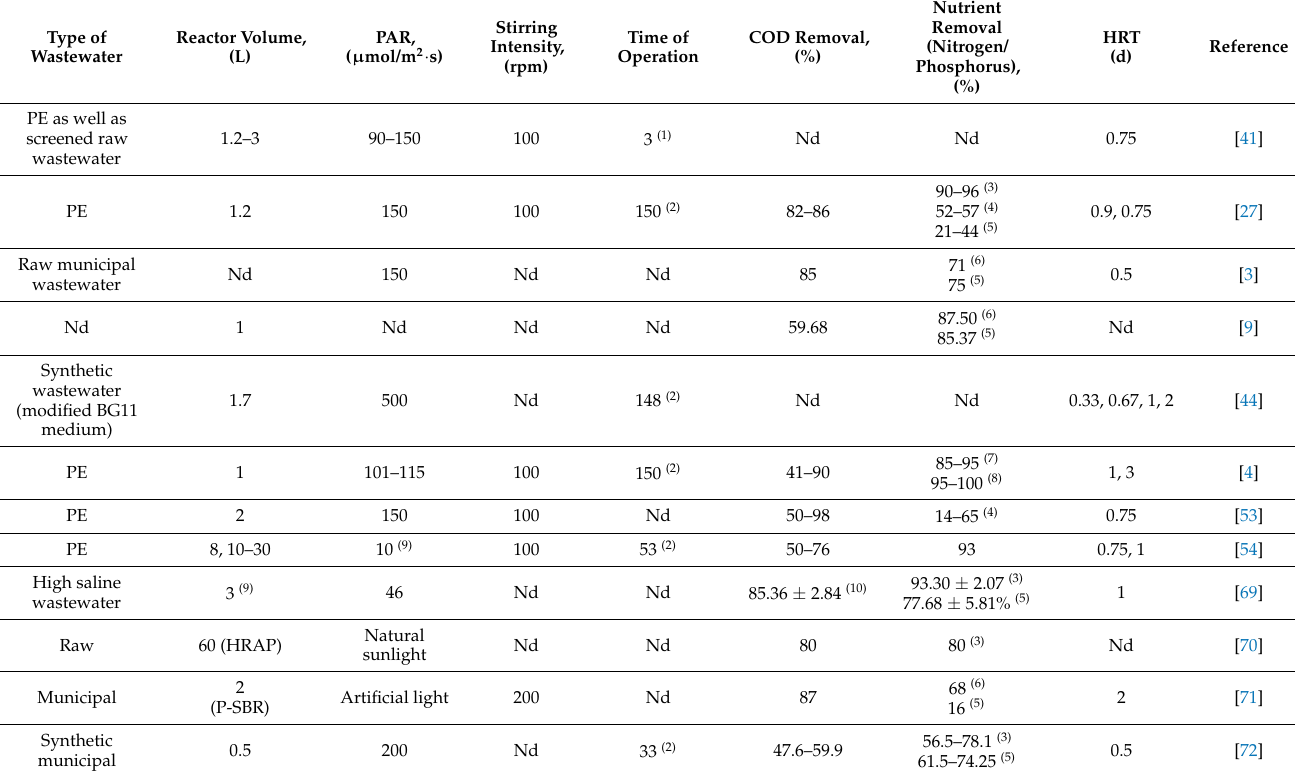
Table 4. Operational conditions and results of COD as well as nutrient removals from some recent